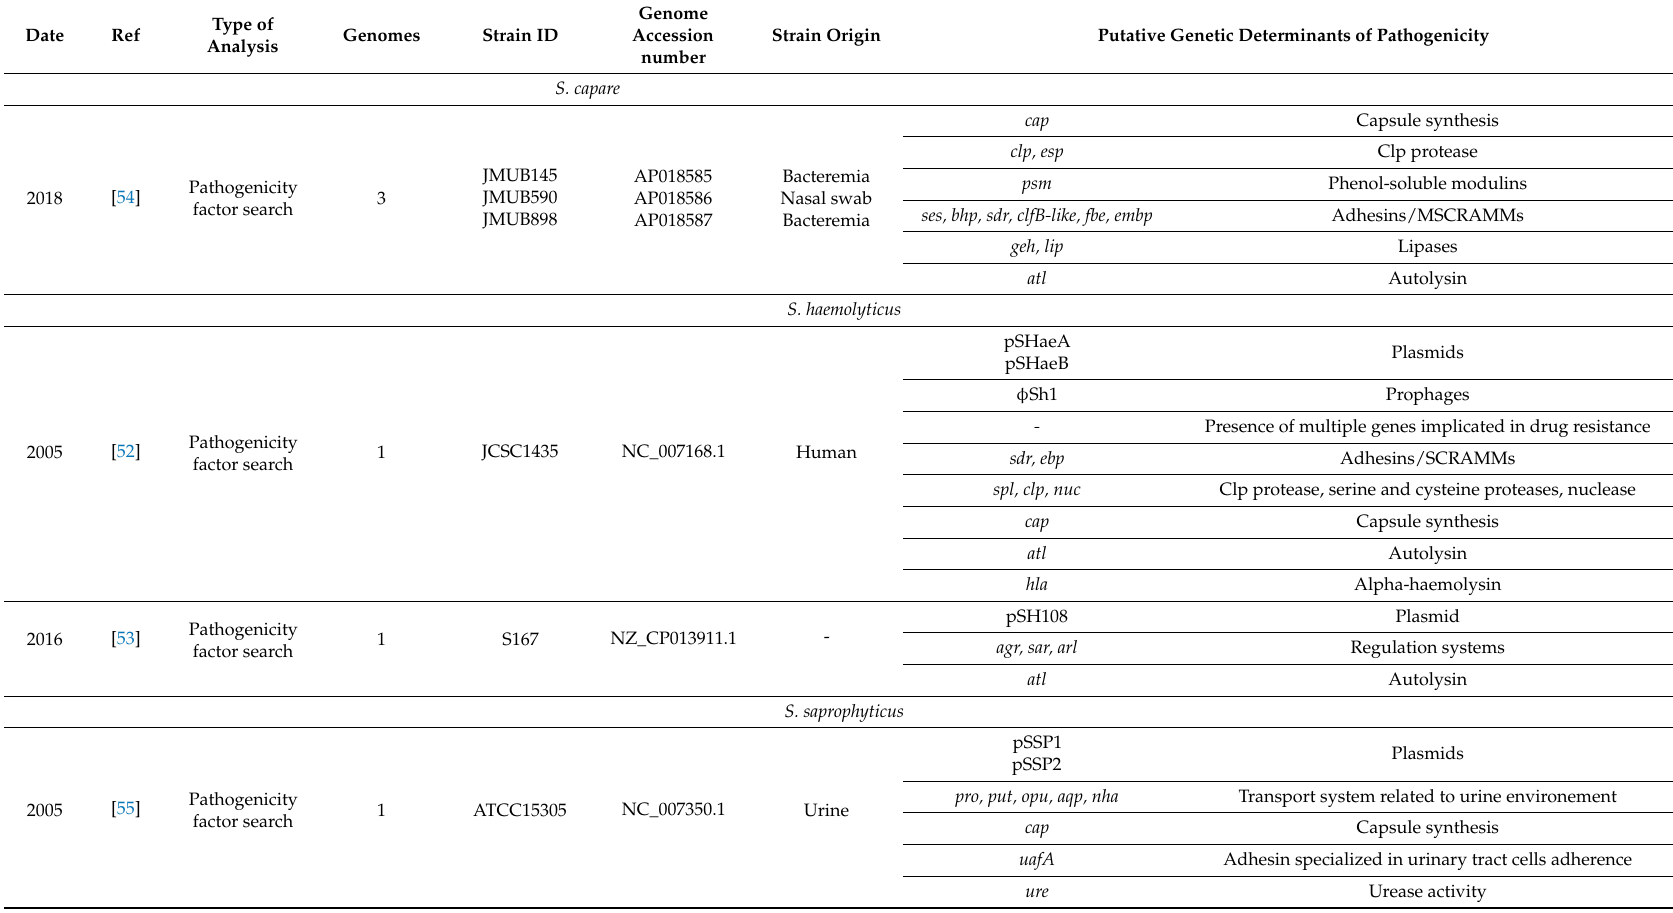
Table 4. Staphylococcus caprae, haemolyticus, and saprophyticus whole-genome-based studies to determine virulence